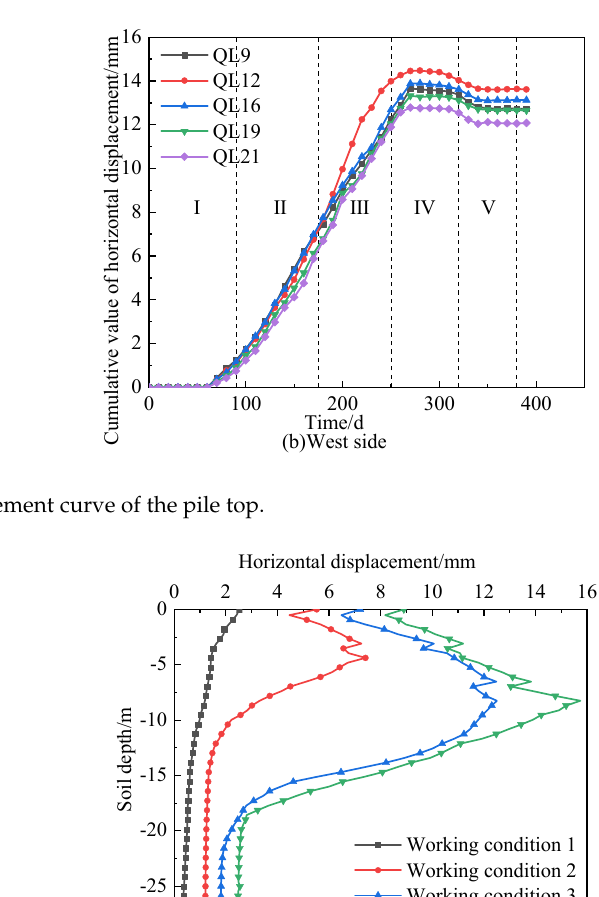
Figure 8. Horizontal displacement curve of the pile top.